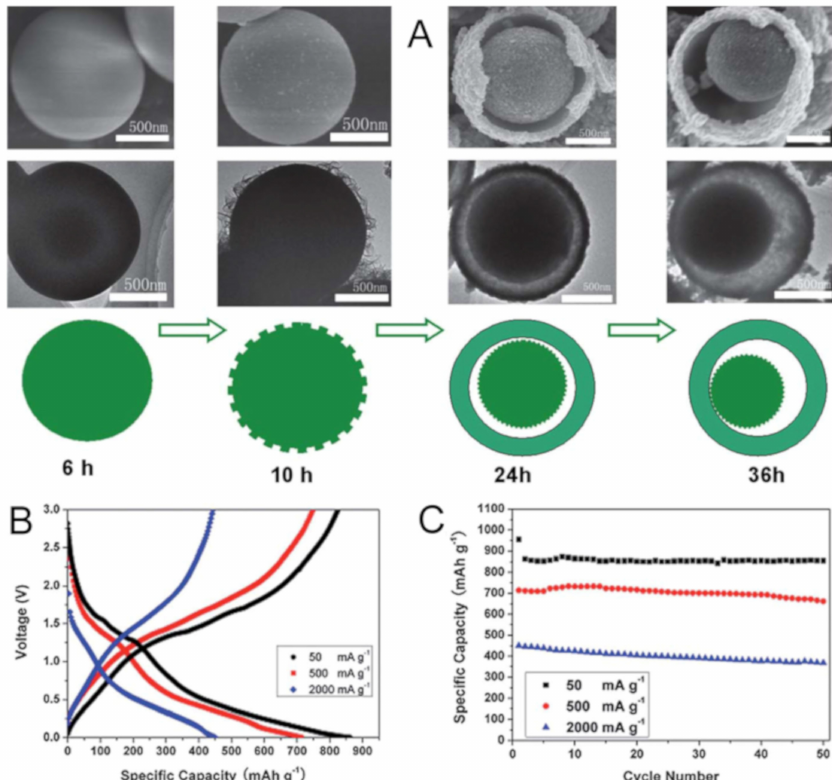
Figure 10. ( A ) Schematic illustration of the formation process of yolk–shell MoO 2 spheres by Ostwald ripening and the corresponding SEM and TEM images. ( B ) Charge–discharge voltage profiles of the yolk–shelled MoO 2 electrode at di ff erent current densities. ( C ) Cycling performance. Reproduced with permission from [87]. Copyright The Royal Society of Chemistry,